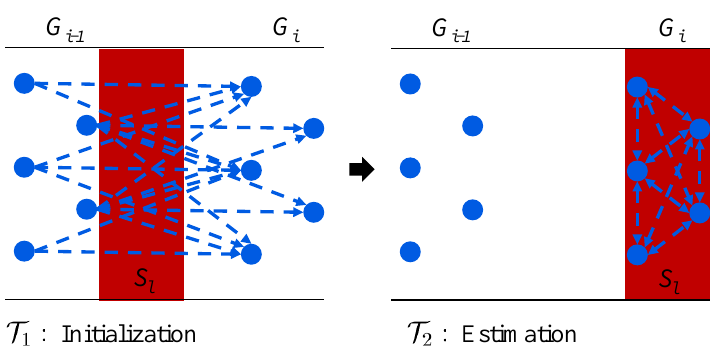
Figure 3. Two phases of the consensus-based